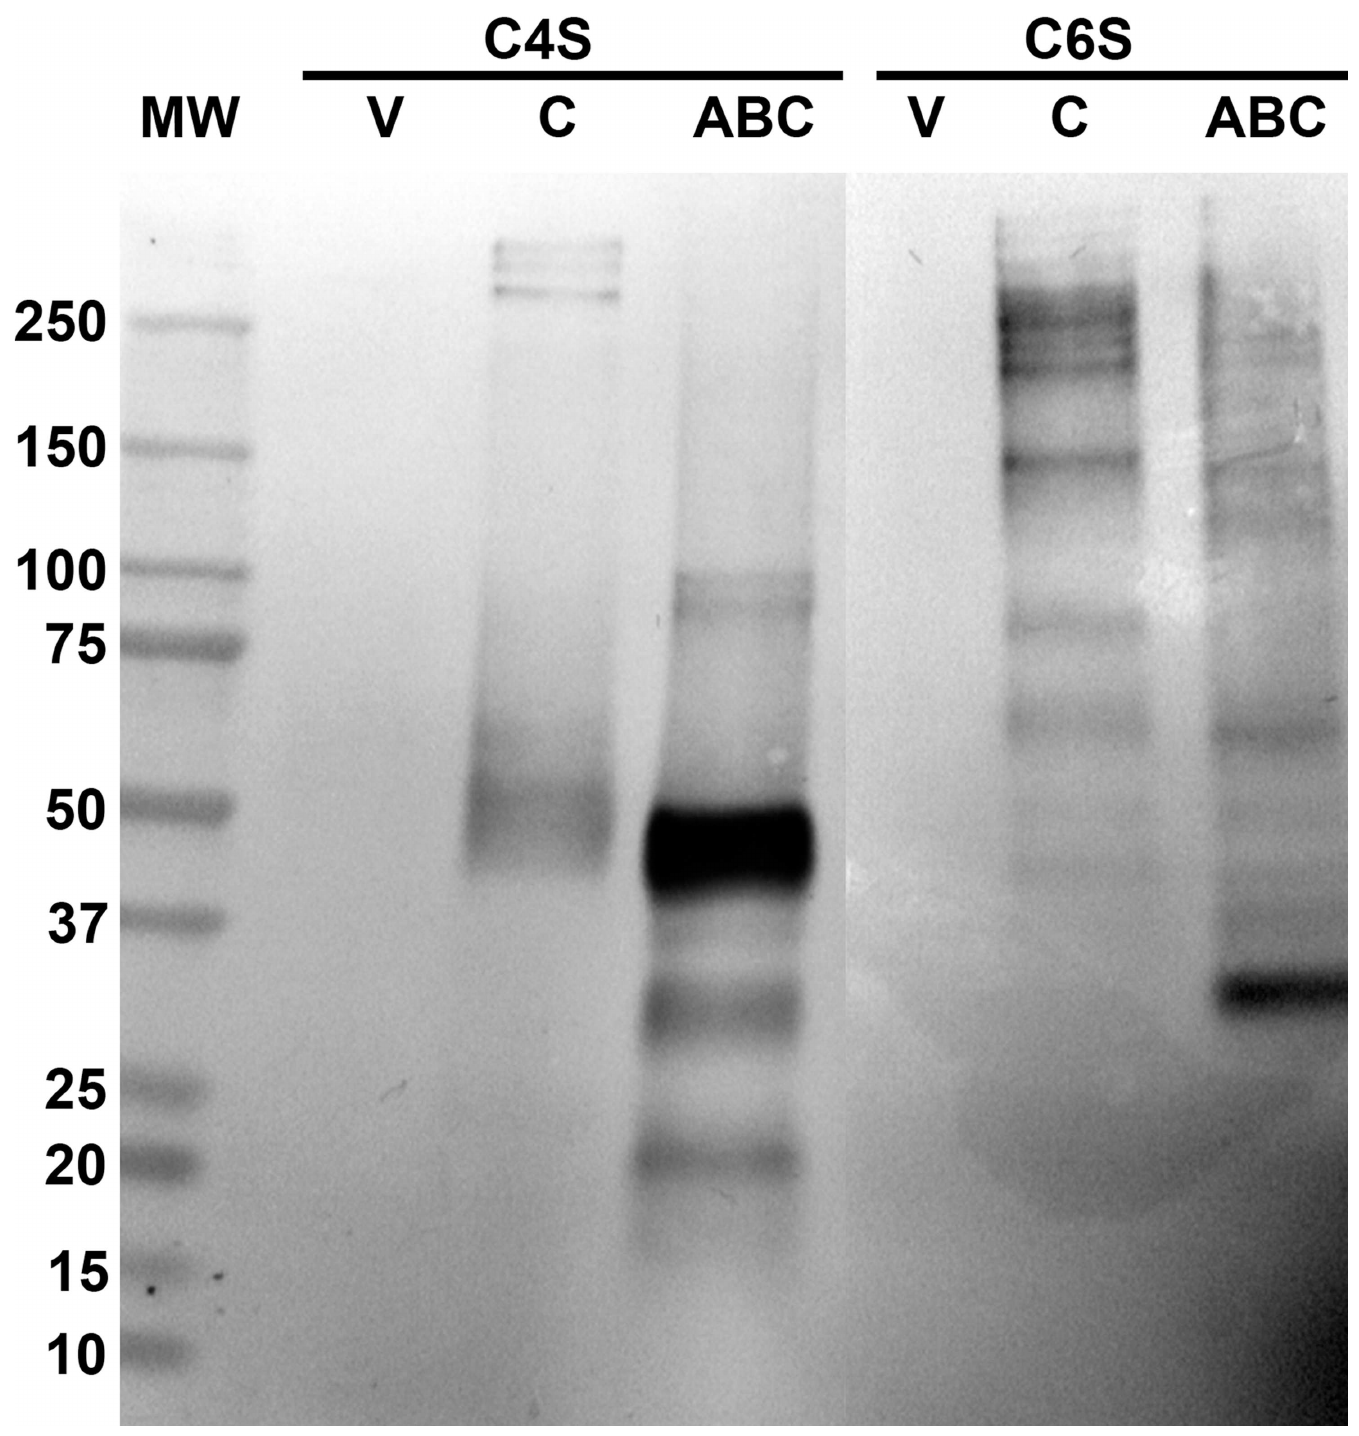
Fig 9. Western analysis of neoepitope immunolabeling of enzyme or vehicle treated proteoglycan extract. Proteoglycan enrichednerve extract (PENE) was obtained as describedin Methods and Materialsand were pretreatedwith vehiclebuffer (V), chondroitinase C (C), or chondroitinase ABC (ABC) prior to 4–15%SDS-PAGE separation and transferred to nitrocellulosefor western analysiswith neoepitopeantibodies. Vehicle treated samples did not reveal any immunoreactivity as expected. Chondroitinase C and chondroitinase ABC treated PENE produceddifferential immunoreactive band indicatingselective degradationof glycosaminoglycans and the productionof Δ CS-A and Δ CS-C. Surprisingly, Chondroitinase C treated PENE was immunoreactive for C4S producingthree distinct bandsof high molecularmass and a broad band at M r = 45-55kD.Chondroitinase ABC eliminated the high